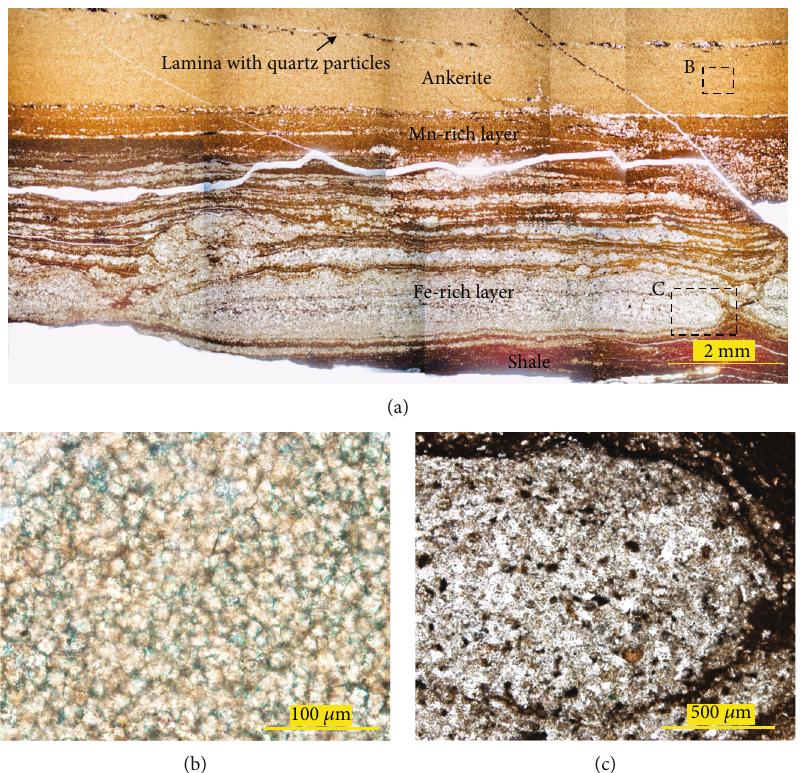
Figure 3: (a) Optical pictures of the transient zone from black shale to dolomite nodule, which was taken from area A in Figure 1(d) with microscopic transmission light. The ruler is 2 mm. The lamina pointed with an arrow is a detrital mineral layer containing quartz particles. (b) Ampli fi ed image of the dolomite crystals with blue color at their outer rims after dyed with alizarin red, which was a sign of ankerite. The ruler is 100 μ m. (c) Ampli fi ed image of the convergent part of a quartz debris lens in the host black shale. The ruler is 500 μ m.